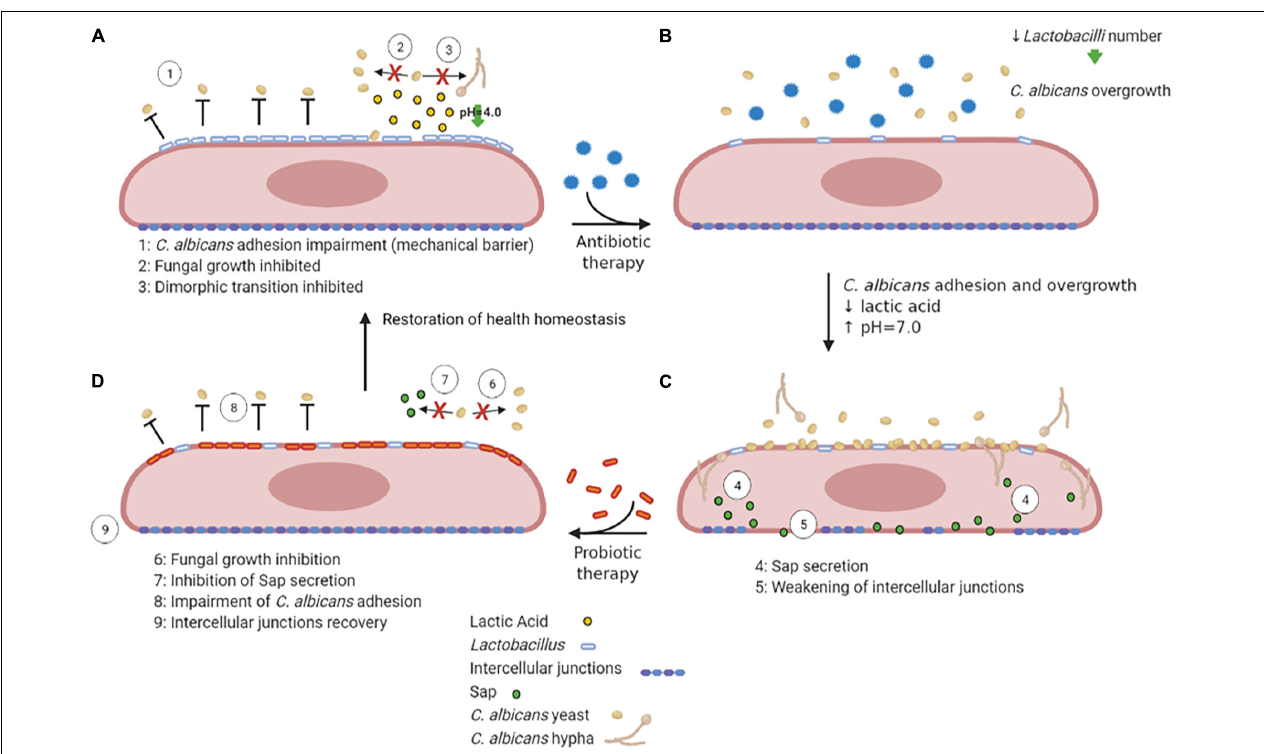
FIGURE 4 | VVC inhibition by Lactobacilli , antibiotic therapy dysbiosis and probiotic therapy recovery. A healthy vaginal epithelium is colonized by Lactobacilli ; the latter outcompete C. albicans for adhesion through several mechanisms, such as production of lactic acid, which also inhibits C. albicans yeast-to-hypha transition (A) . Upon antibiotic use, the decrease in Lactobacilli number is followed by an increase in intravaginal pH, followed by C. albicans overgrowth (B) . The dismicrobism allows for C. albicans overgrowth and adhesion; moreover, the Sap secretion by the fungus causes the weakening of epithelial intercellular junctions (C) . The administration of a probiotic therapy restores Lactobacilli colonization, impairs C. albicans adhesion and inhibits Sap secretion by the fungus, allowing the recovery of intercellular junctions’ integrity, ultimately allowing to restore the health homeostasis status (D) (created with